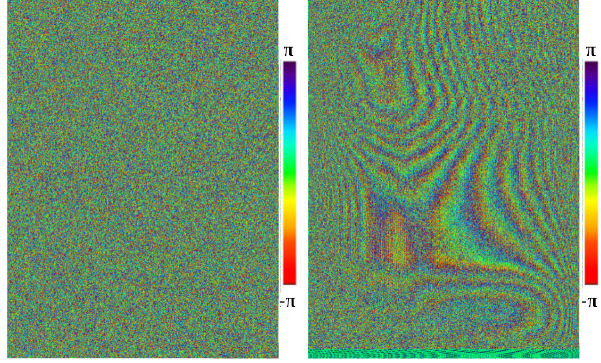
Figure 7. Phase of the co-polar correlation coefficient for the calibrated SARAT data acquired along track 19.